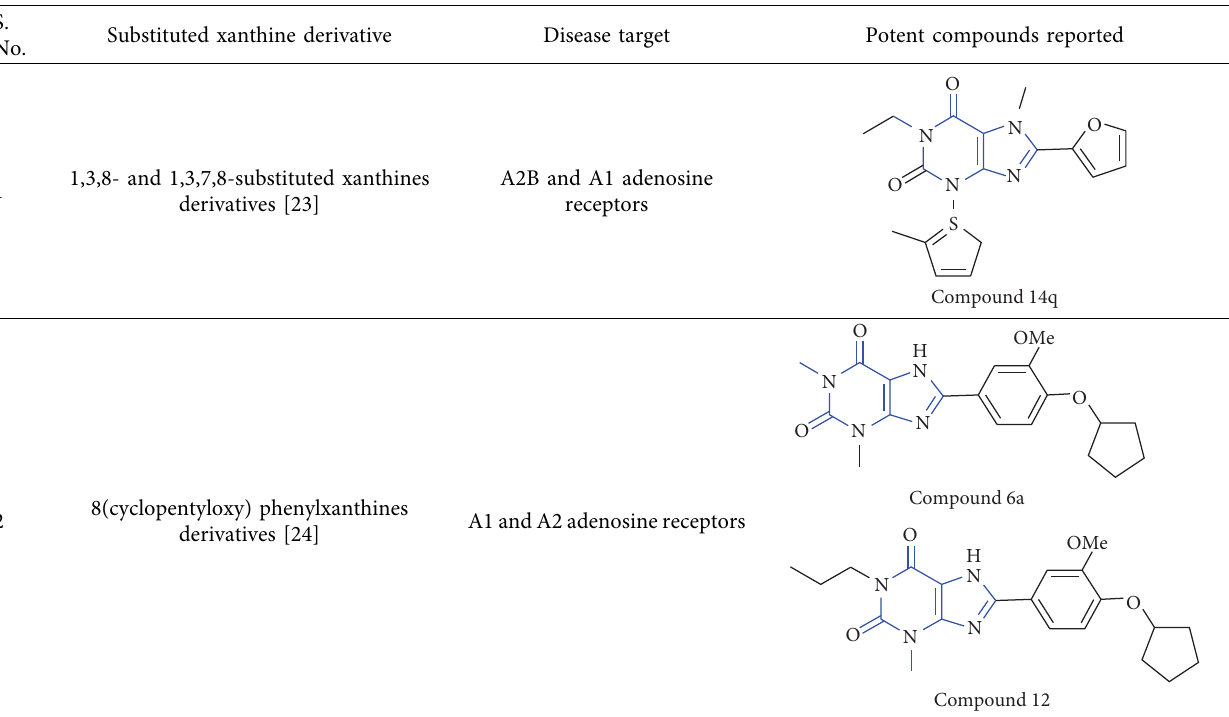
Scheme 23: Schematic synthesis of xanthine derivatives. Table 2: Reported potent compounds of xanthines and their